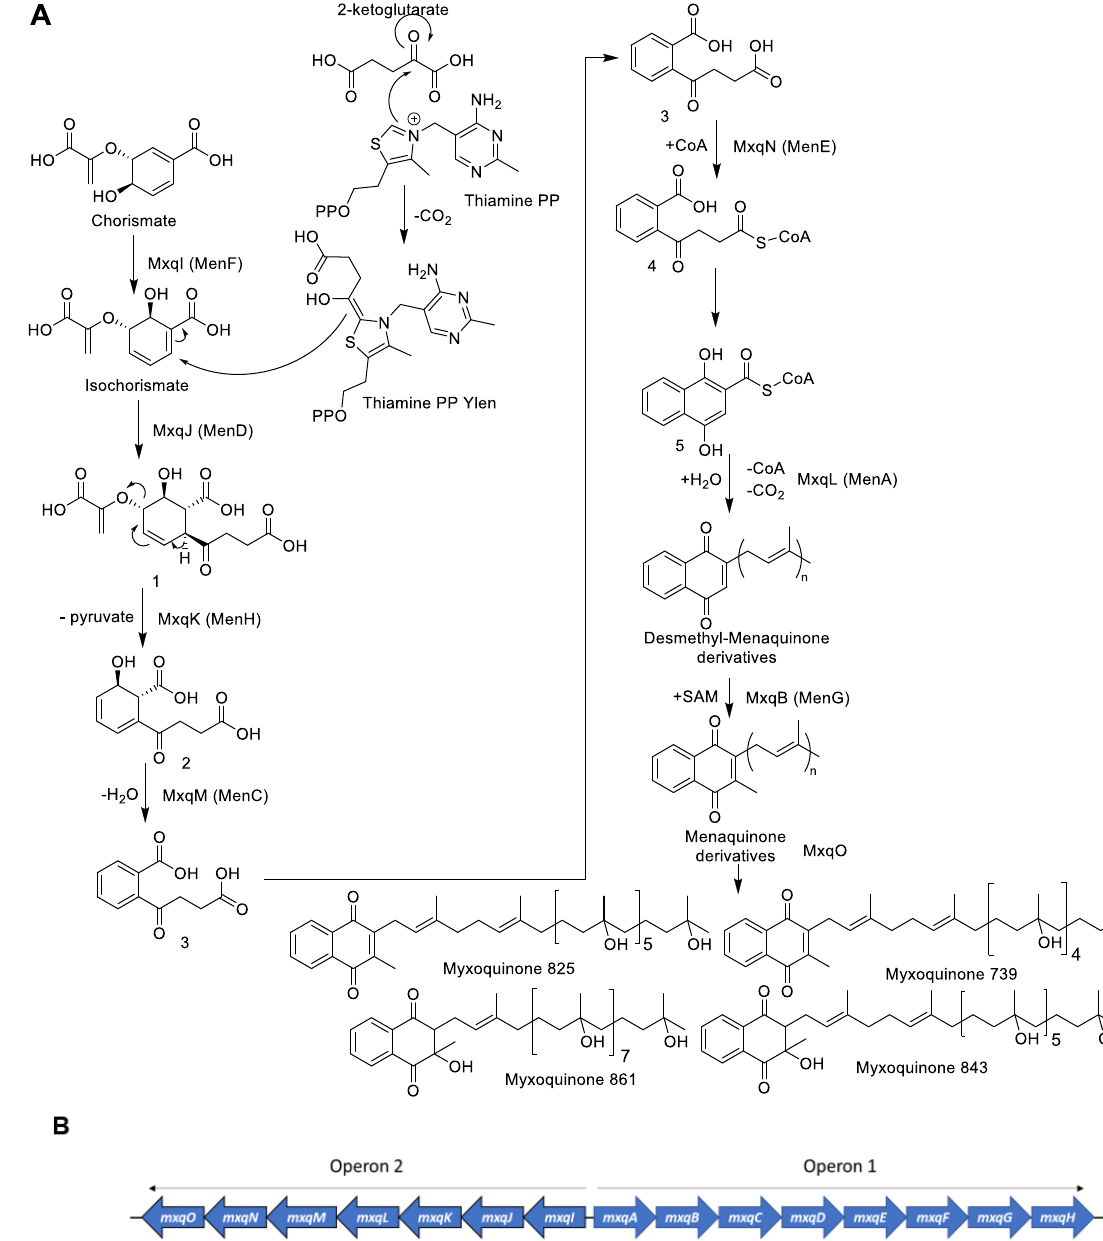
Figure 5. ( A ) Proposed biosynthesis of the myxoquinones. ( B ) Schematic overview for the identified myxoquinone biosynthetic gene cluster from MCy9049.